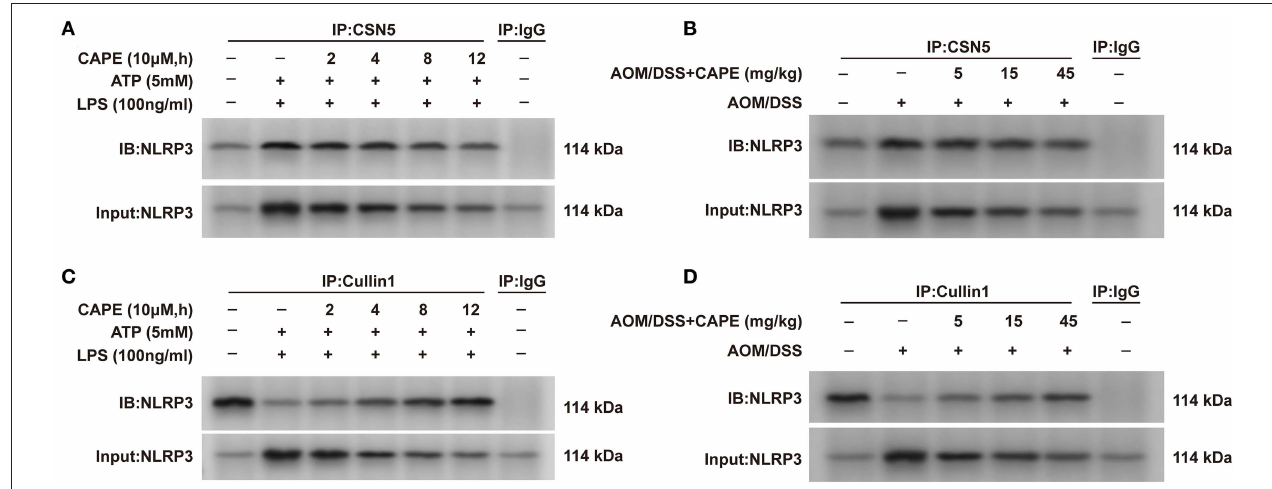
FIGURE 7 | CAPE suppresses the interaction between NLRP3 and CSN5, but enhances the interaction between NLRP3 and Cullin1. (A,C) Immunoprecipitation assay using cell lysates with anti-CSN5 or anti-Cullin1 antibodies; mouse IgG was used as control. (B,D) Colon tissues lysates were subjected to immunoprecipitation assays with anti-CSN5 or anti-Cullin1 antibodies; mouse IgG was used as control. ( n =